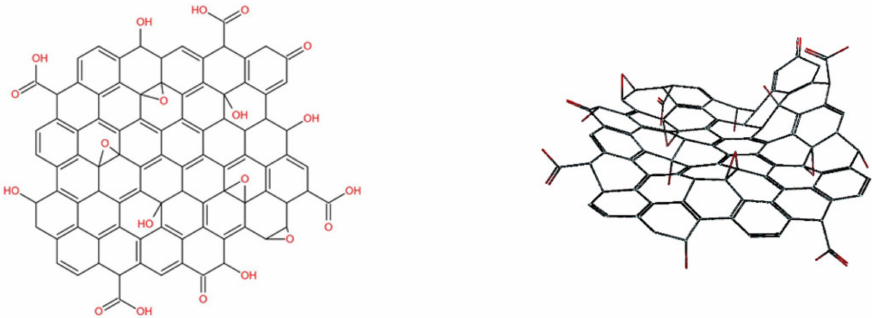
Figure 1. Plane structure ( left ) and solid structure ( right ) of GO (bond line type).